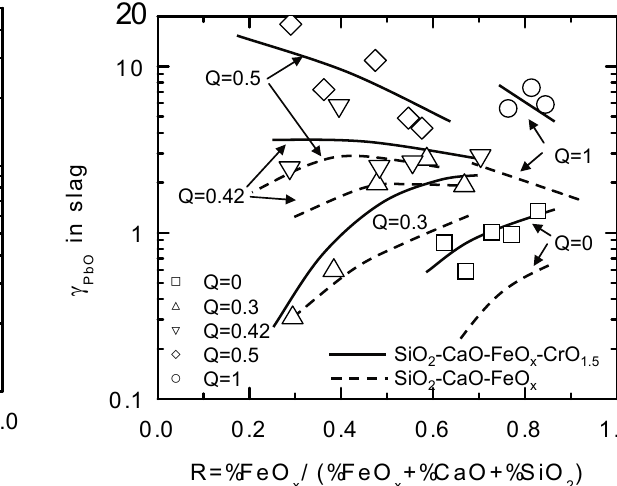
Figure 5. The activity coefficient of PbO in the CaO-SiO 2 - FeO x -5mass%NaO 0:5 slag at 1573 K.